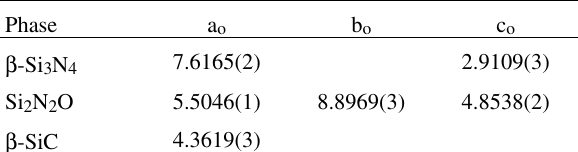
Table 3. Mean unit-cell parameters for Silicon phases. Phase a o b